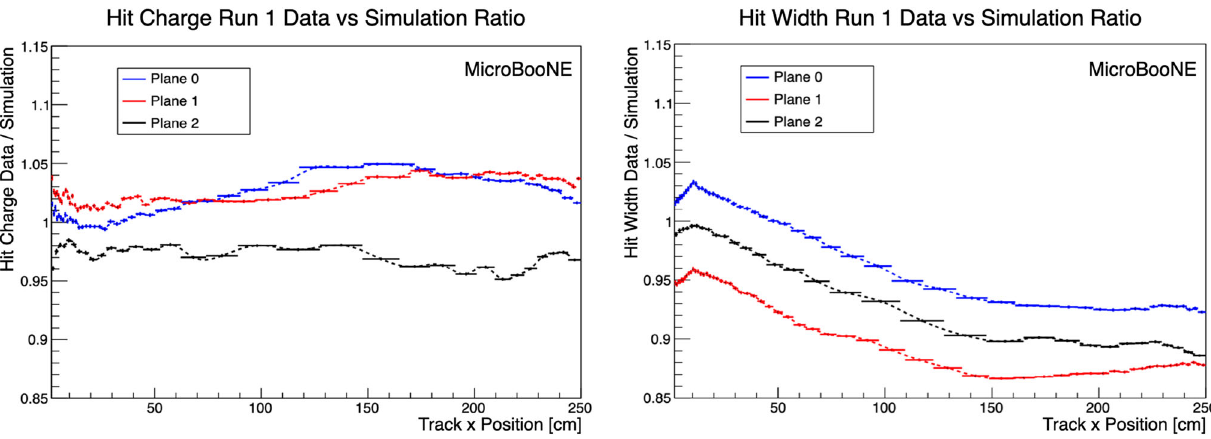
Fig. 5 Ratios (data/simulation) and fitted simulation modification functions for mean hit charge and mean hit width vs. x on each of the three wire planes. The solid lines are the bin values, with error bars